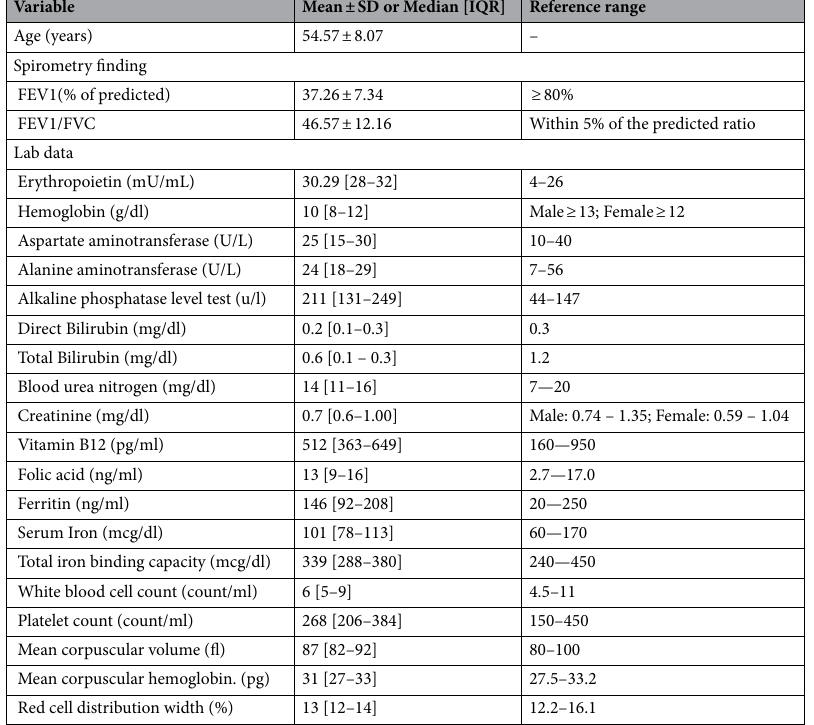
Table 1. Baseline demographic and clinical features of COPD patients.